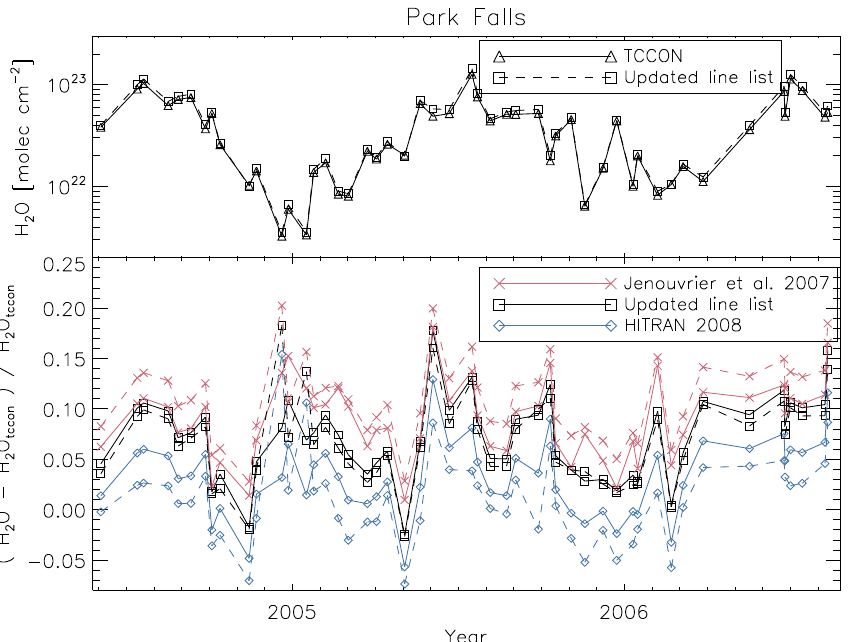
Fig. 7. H 2 O FTS retrieval accuracy for Park Falls. Top: time series of the fitted H 2 O columns using TCCON’s GFIT algorithm at 1.6µm, compared to using our updated line list in the 4174–4300cm − 1 range (2.3µm). Bottom: time series of the relative differences with TCCON for all different line lists. Solid and dashed lines are for the 4174–4300cm − 1 and 4212–4248cm − 1 window,